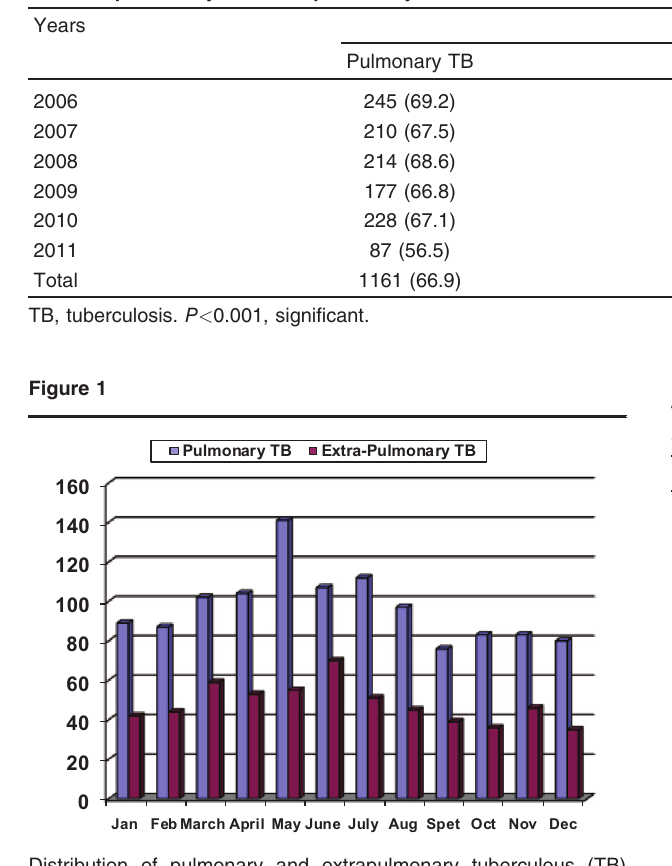
Table 2 Distribution of pulmonary and extrapulmonary cases during the period of the study (2006 – 2011) and statistical analysis between pulmonary and extrapulmonary cases